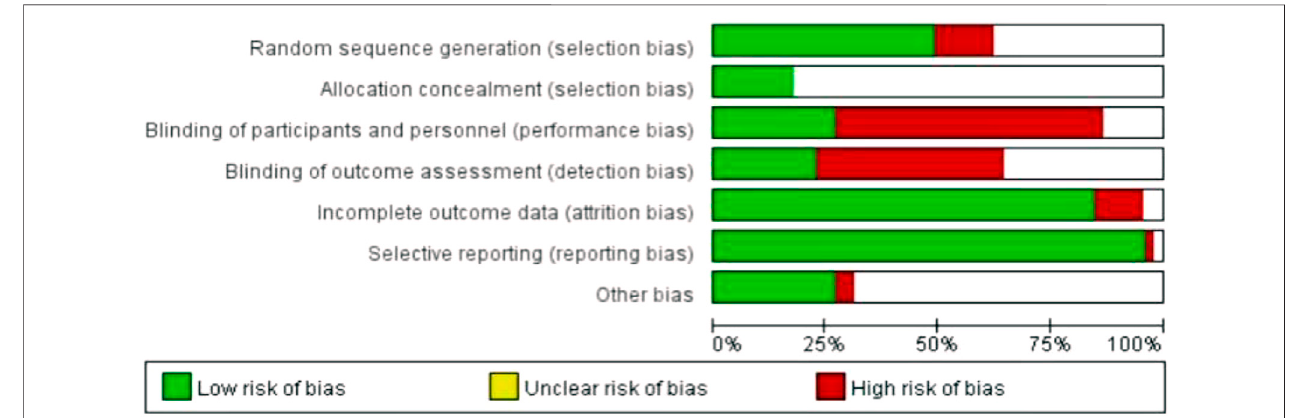
FIGURE 2 | Risk of bias in the included